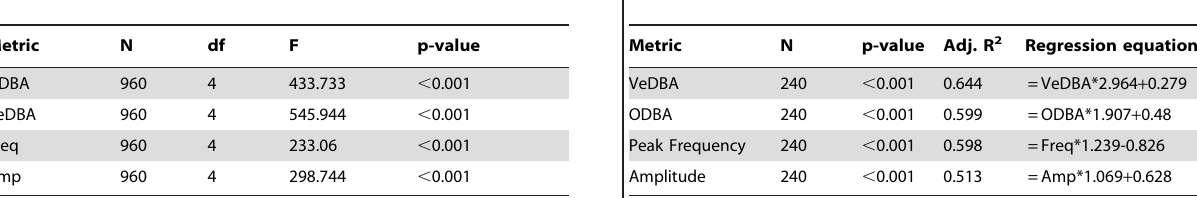
Table 2. Summary of the statistics for the regression between the metrics (VeDBA, ODBA, Peak Frequency and Amplitude) and speed, with data for all substrates/inclines